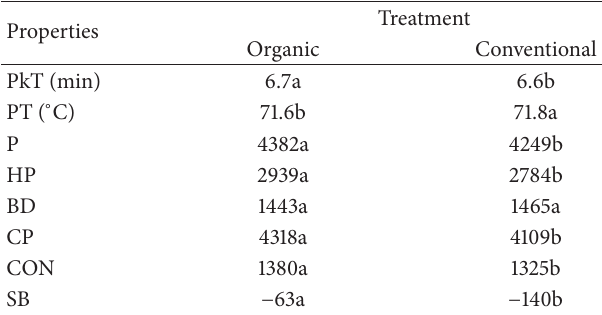
Table 3: Amylographic characteristics (cP) of rice cultivars as affected by treatments (conventional or